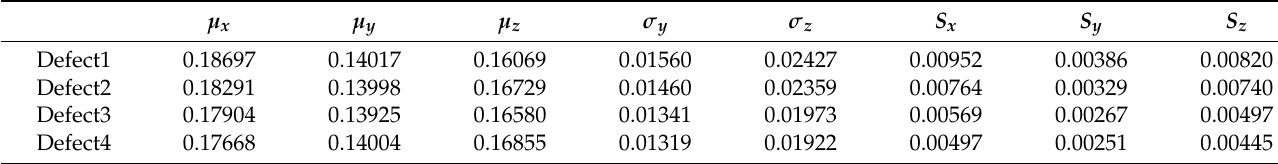
Table 3. Color characteristic values of each